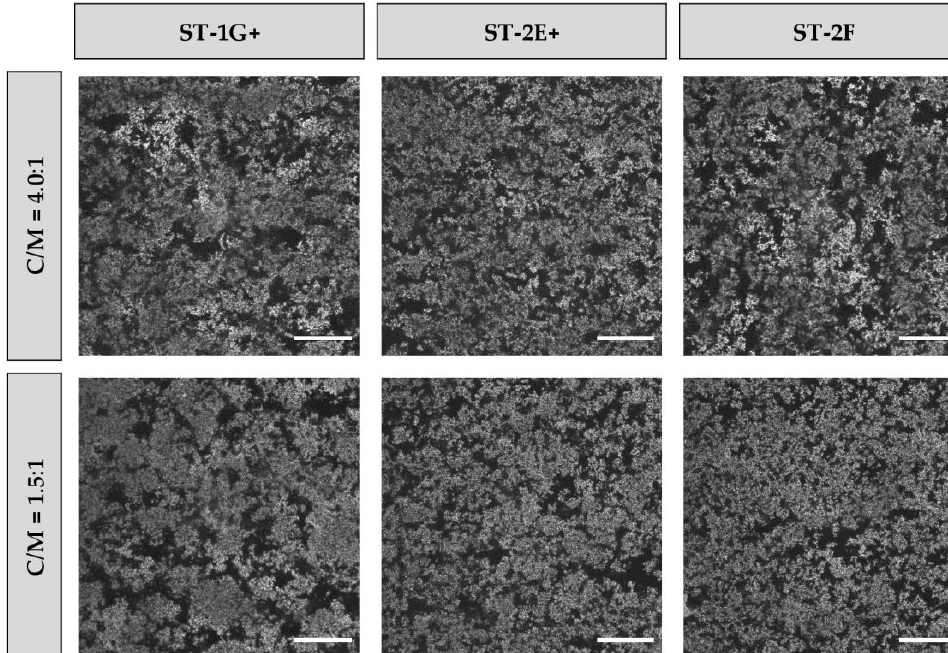
Figure 4. Confocal laser scanning micrographs of the protein phase of stirred gels after 7 d of cold storage. Gels were produced from base milk with casein:whey protein ratio of 4.0:1 or 1.5:1 by inoculation with direct starters of high acidification activity and fermentation at 37 °C. Proteins appear in white, serum in black. Scale bar, 50 μm.